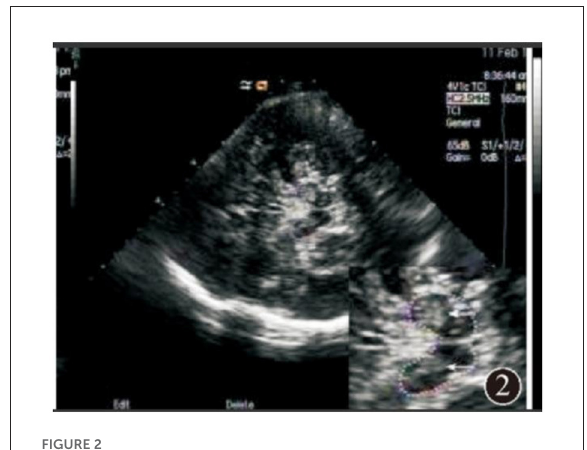
FIGURE2 Abnormal substantia nigra